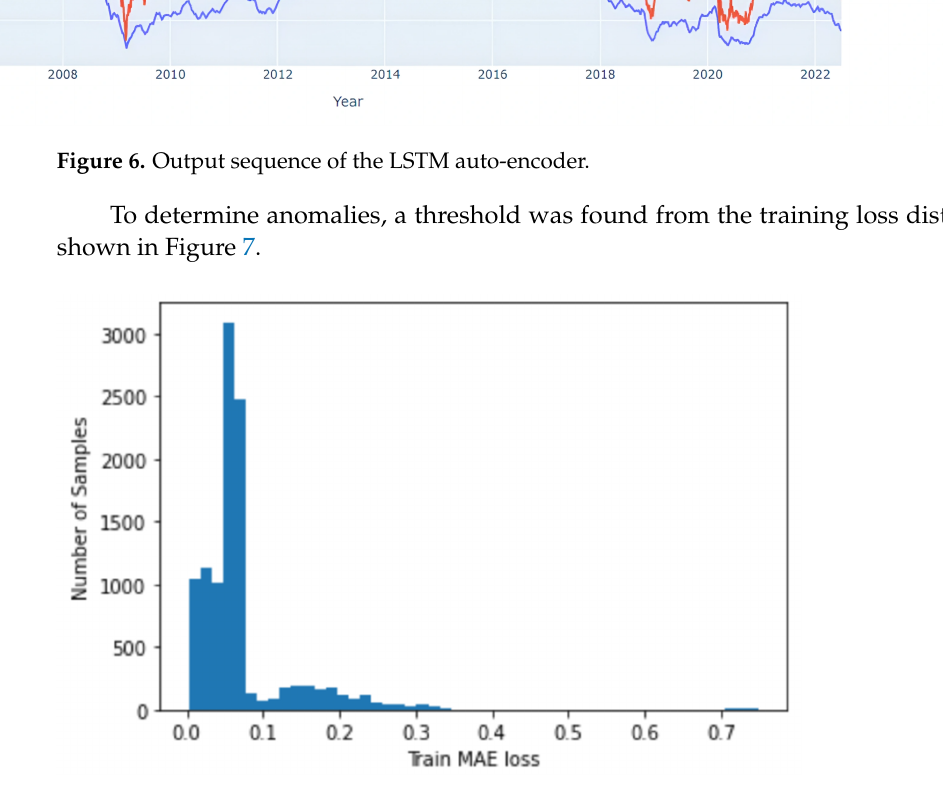
Figure 7. The training loss distribution of the LSTM